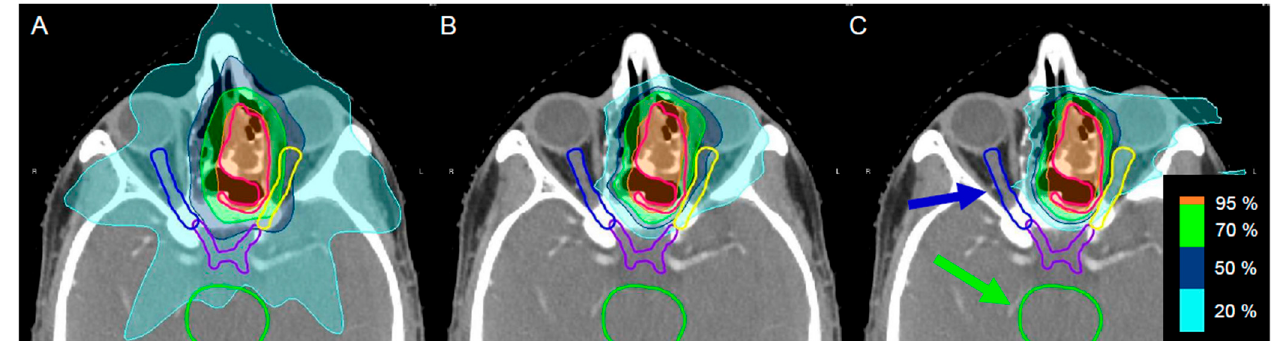
Figure 1. Illustration of the different treatment techniques, shown on a representative booster plan for the gross tumor volume (red) in the paranasal sinus region. The conventional treatment method (( A ) volumetric modulated arc therapy) shows a higher dose delivered to organs at risk, e.g., the chiasm (purple), both optic nerves (yellow and blue), and the brainstem (green). The dose distribution of the pencil beam scanning technique with ( B ) protons and ( C ) C-ions show better sparing of the organs at risk, especially visible in the right optical nerve and brainstem, while achieving a comparable tumor coverage.